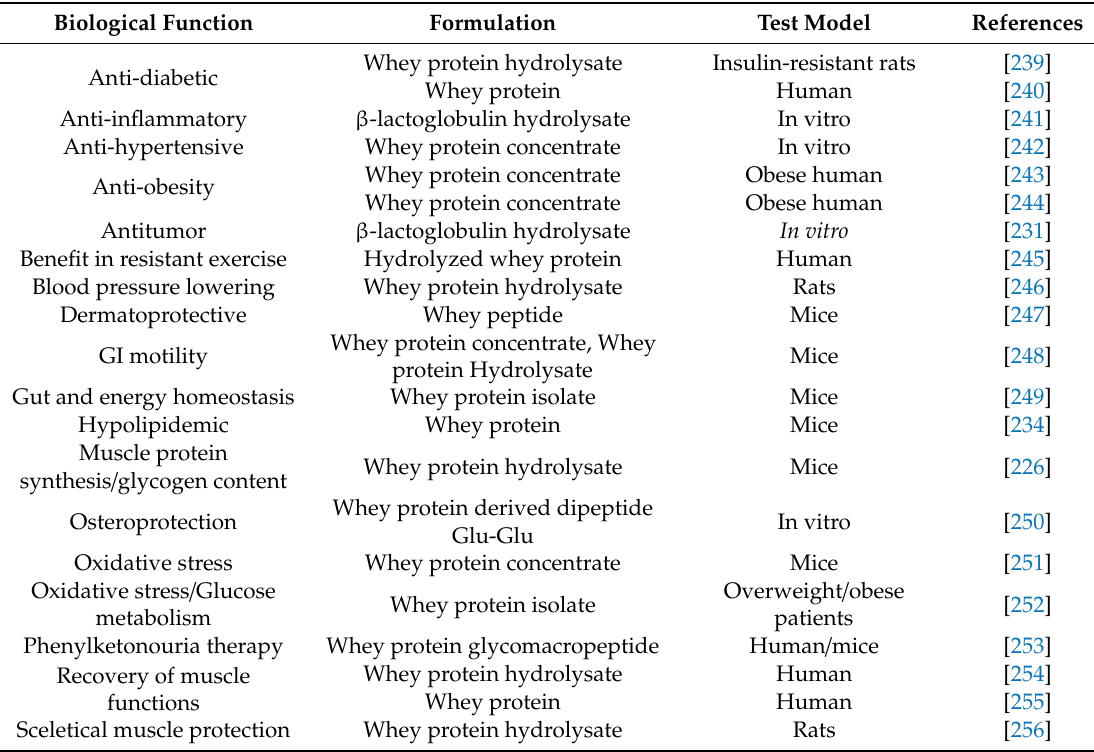
Table 4. Whey protein edible film formation from whey protein isolate (WPI) and whey protein isolate (WPI) and their functional